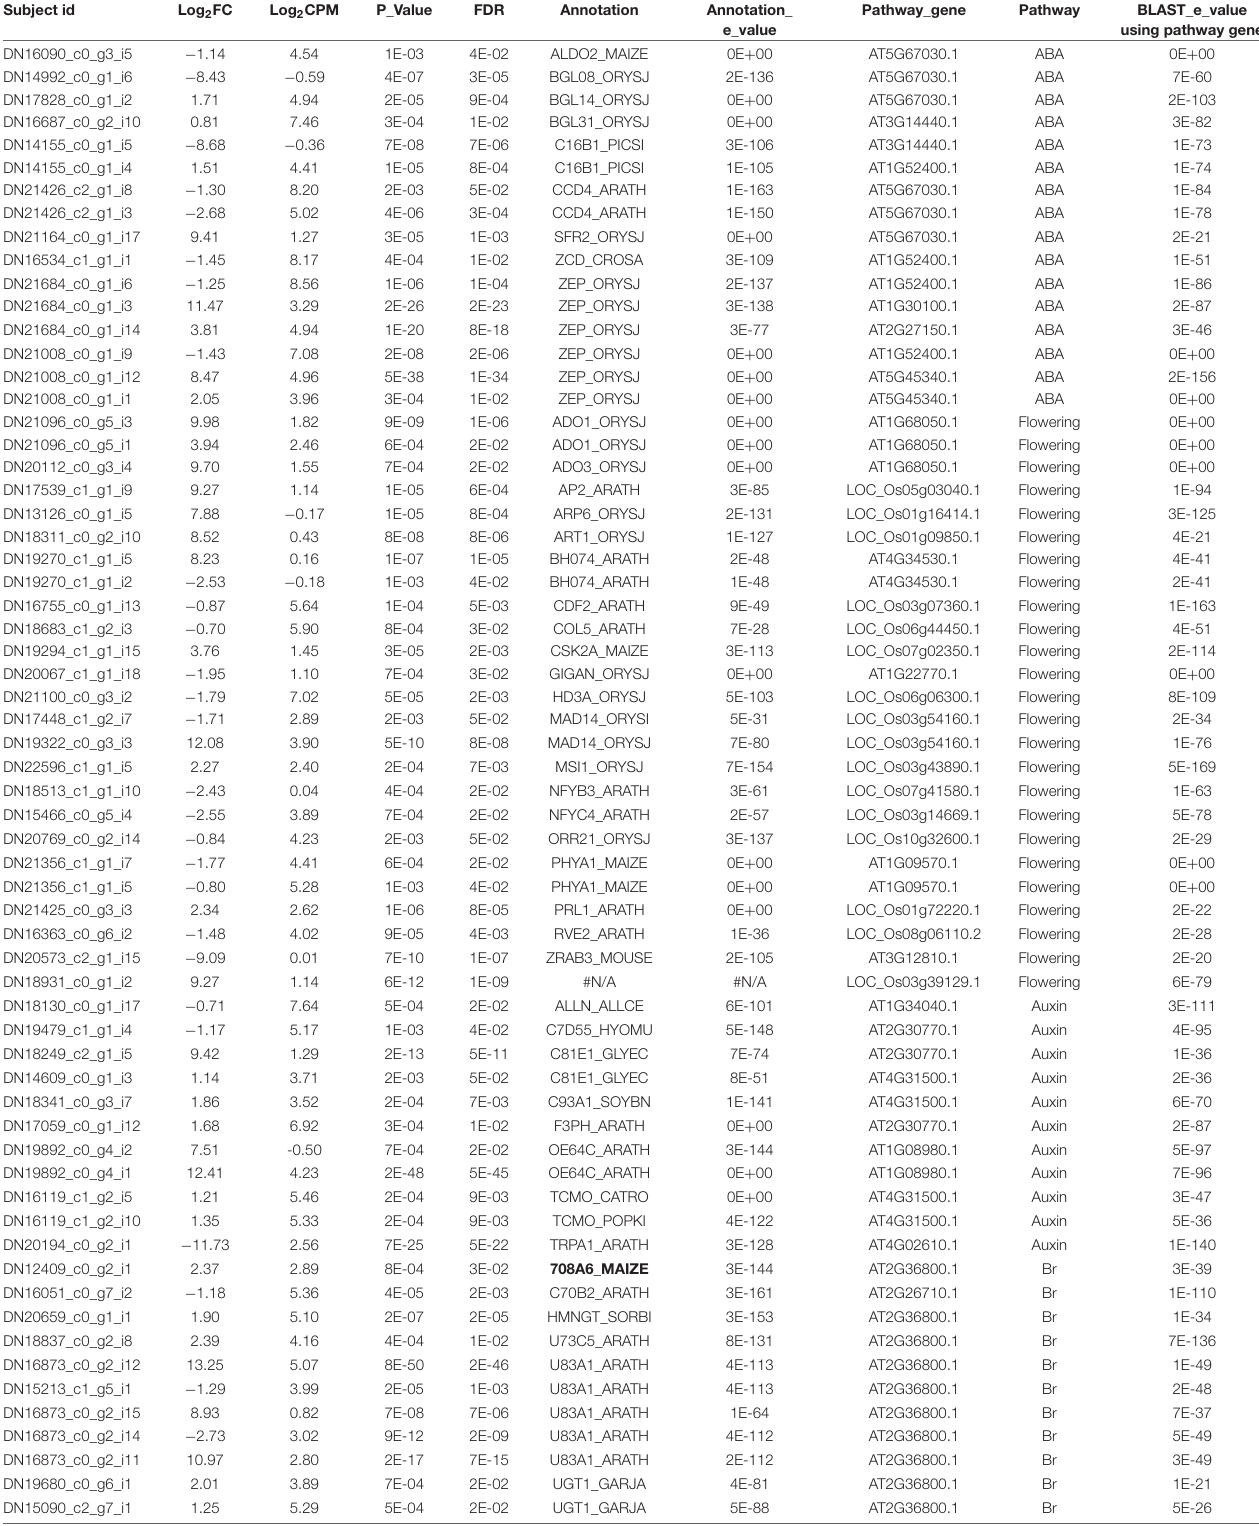
TABLE 1 | Differentially expressed transcripts (DETs) of flowering pathway, hormone genes, MADS-box genes, and mitogen-activated protein kinase (MAPK) genes in maize new leaves from 83-day old